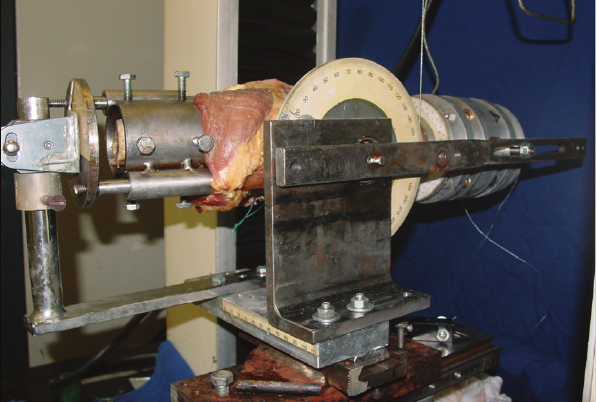
Figure 2 - Image of the knee fixed to the